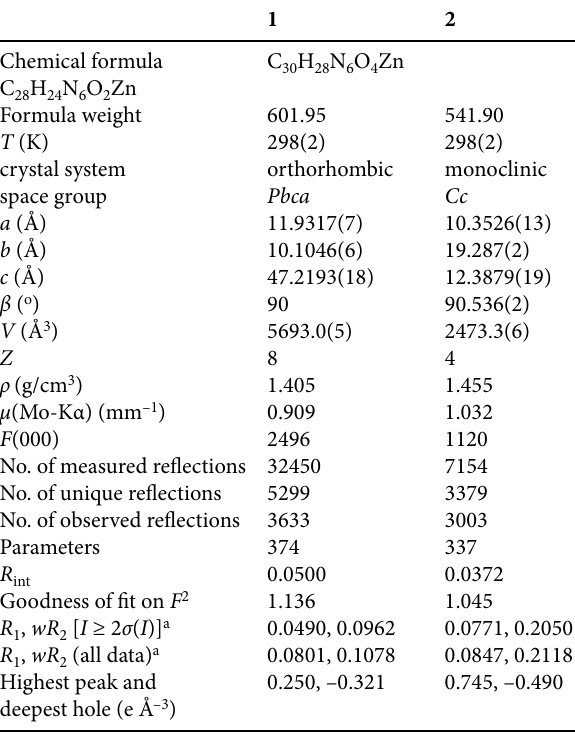
Table 1. Crystallographic and experimental data for the complexes.